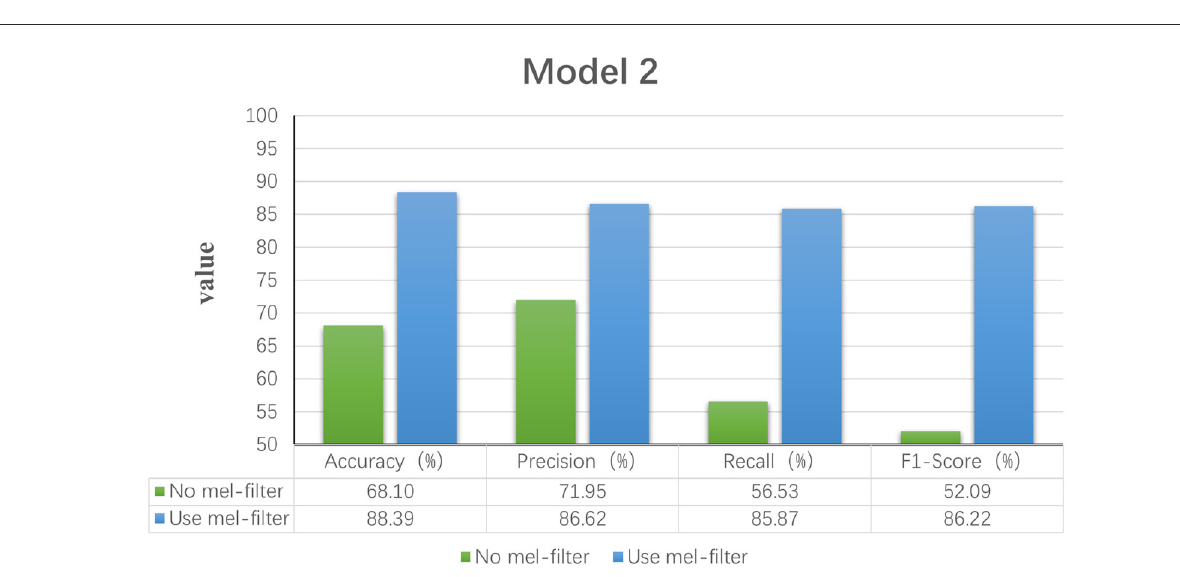
FIGURE4 Statistical graphs of the evaluation results of the model with the addition of Mel filter vs.